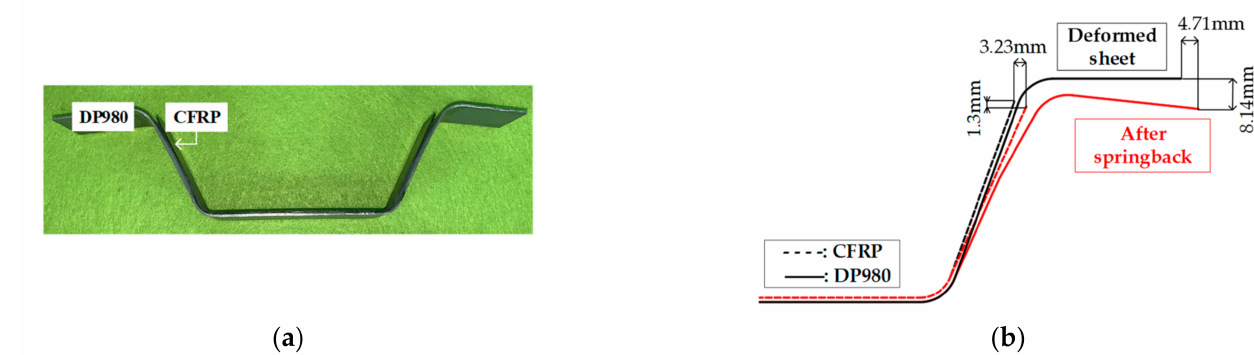
Figure 14. Result of U-shape drawing test: ( a ) manufactured part; ( b ) dimensions of part after springback.